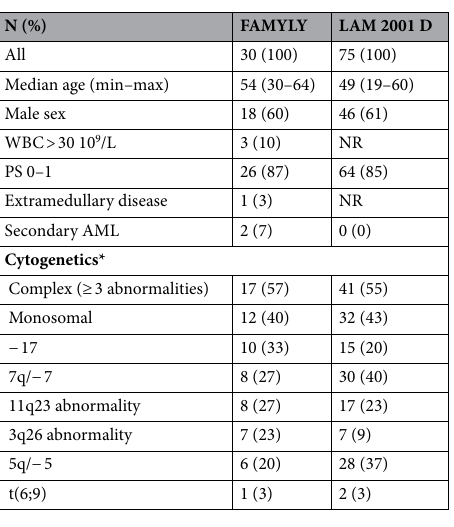
Table 1. Patient characteristics. NR not reported, PS performance status, WBC white blood count. *The sum exceeds the total because of the presence of multiple abnormalities.